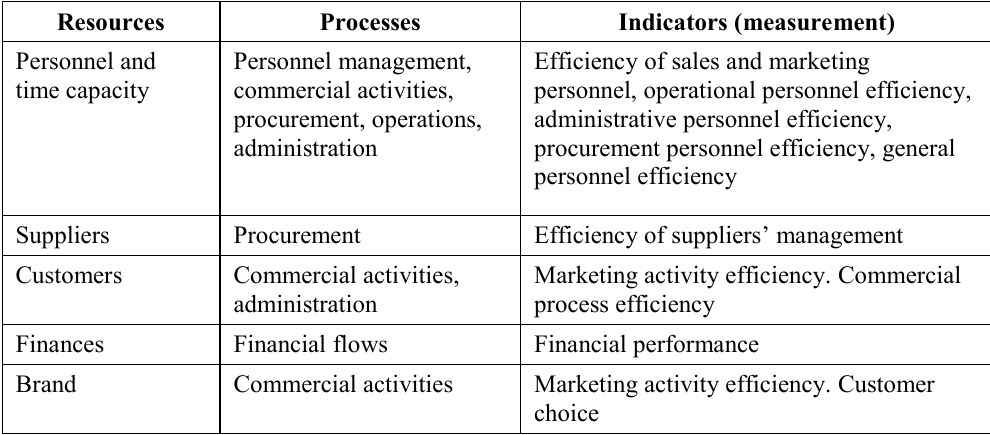
Table 1. Summary of 3PL resources and processes